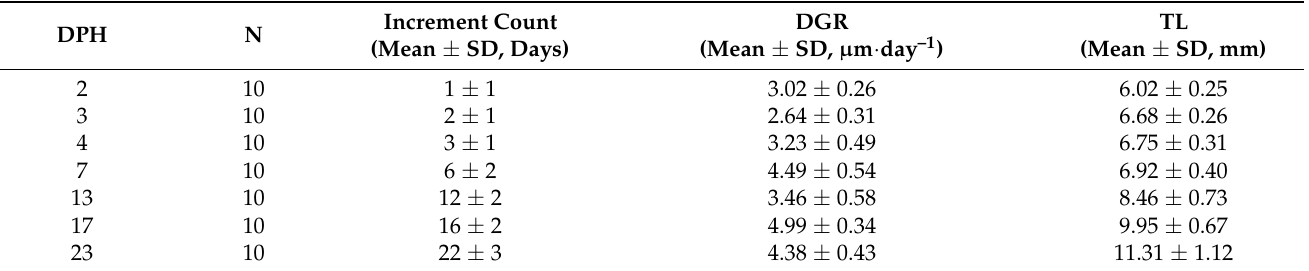
Table 1. Sampling details for each stage of larval and juvenile Sinogastromyzon wui, including